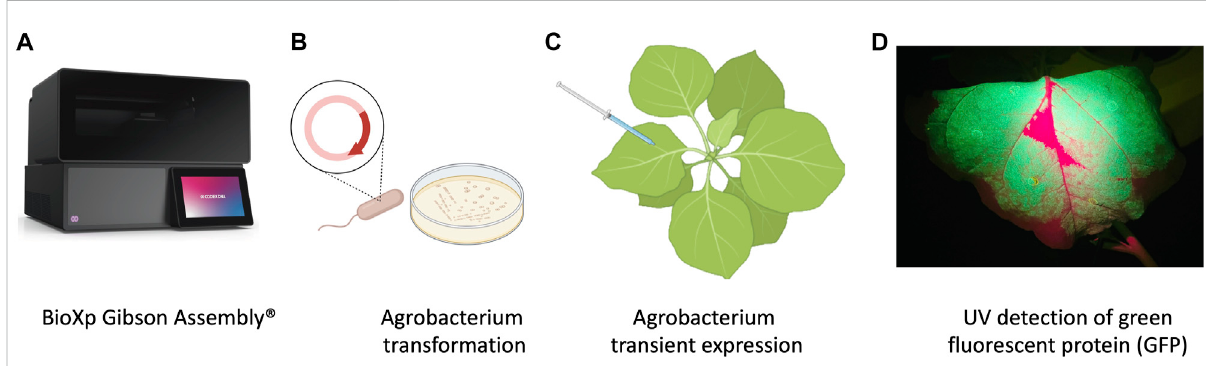
Schematic representation of work fl ow of production of nanobodies in plant system. (A) Cloning with the BioXP 3,250 Gibson Assembly ® . (B) Agrobacterium transformation. (C) Agrobacterium in fi ltrationwasperformedbyusing1 mLneedlelesssyringestoinjectbacteriaintotheabaxialside of the leaves at OD 600 0.3. (D) P2A sequence was used for generating multiple separate proteins from a single mRNA, GFP included in the sequence allowed prescreening of high expression protein in leaves using UV